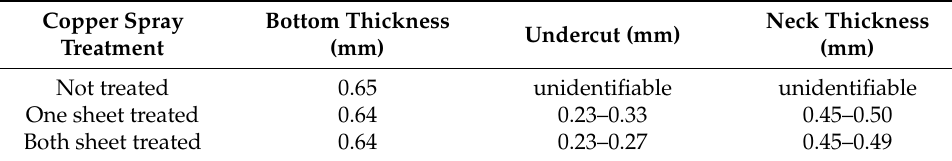
Figure 6. The results of the lap shear tests. The baseline value 200 N is marked with a dotted line.